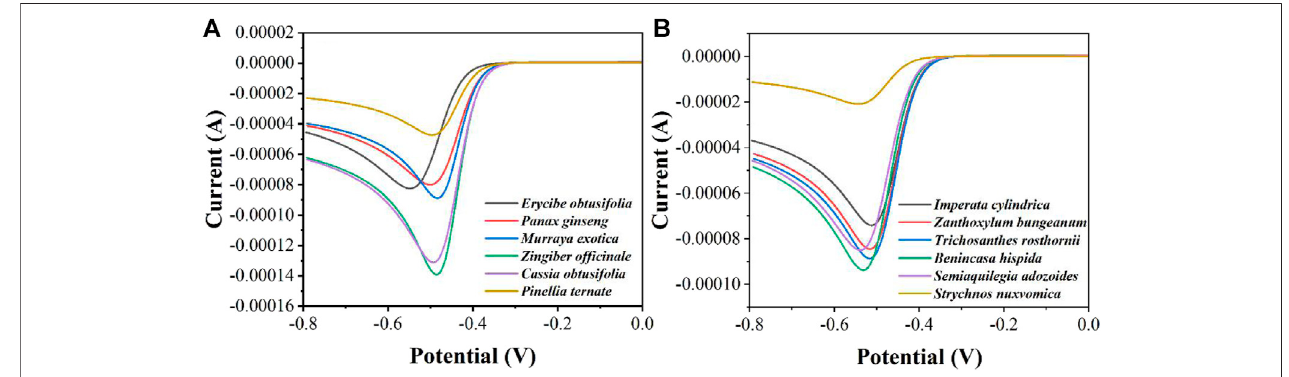
FIGURE4| LSVcurvesof (A) Erycibeobtusifolia,Panaxginseng,Murrayaexotica,Zingiberof fi cinale,Cassiaobtusifolia,Pinelliaternate and (B) Imperatacylindrica, Zanthoxylumbungeanum,Trichosanthesrosthornii,Benincasahispida,Semiaquilegiaadozoides , Strychnosnuxvomica inthepresenceof1 mMH 2 O 2 recordedusinga graphene modi fi ed GCE.